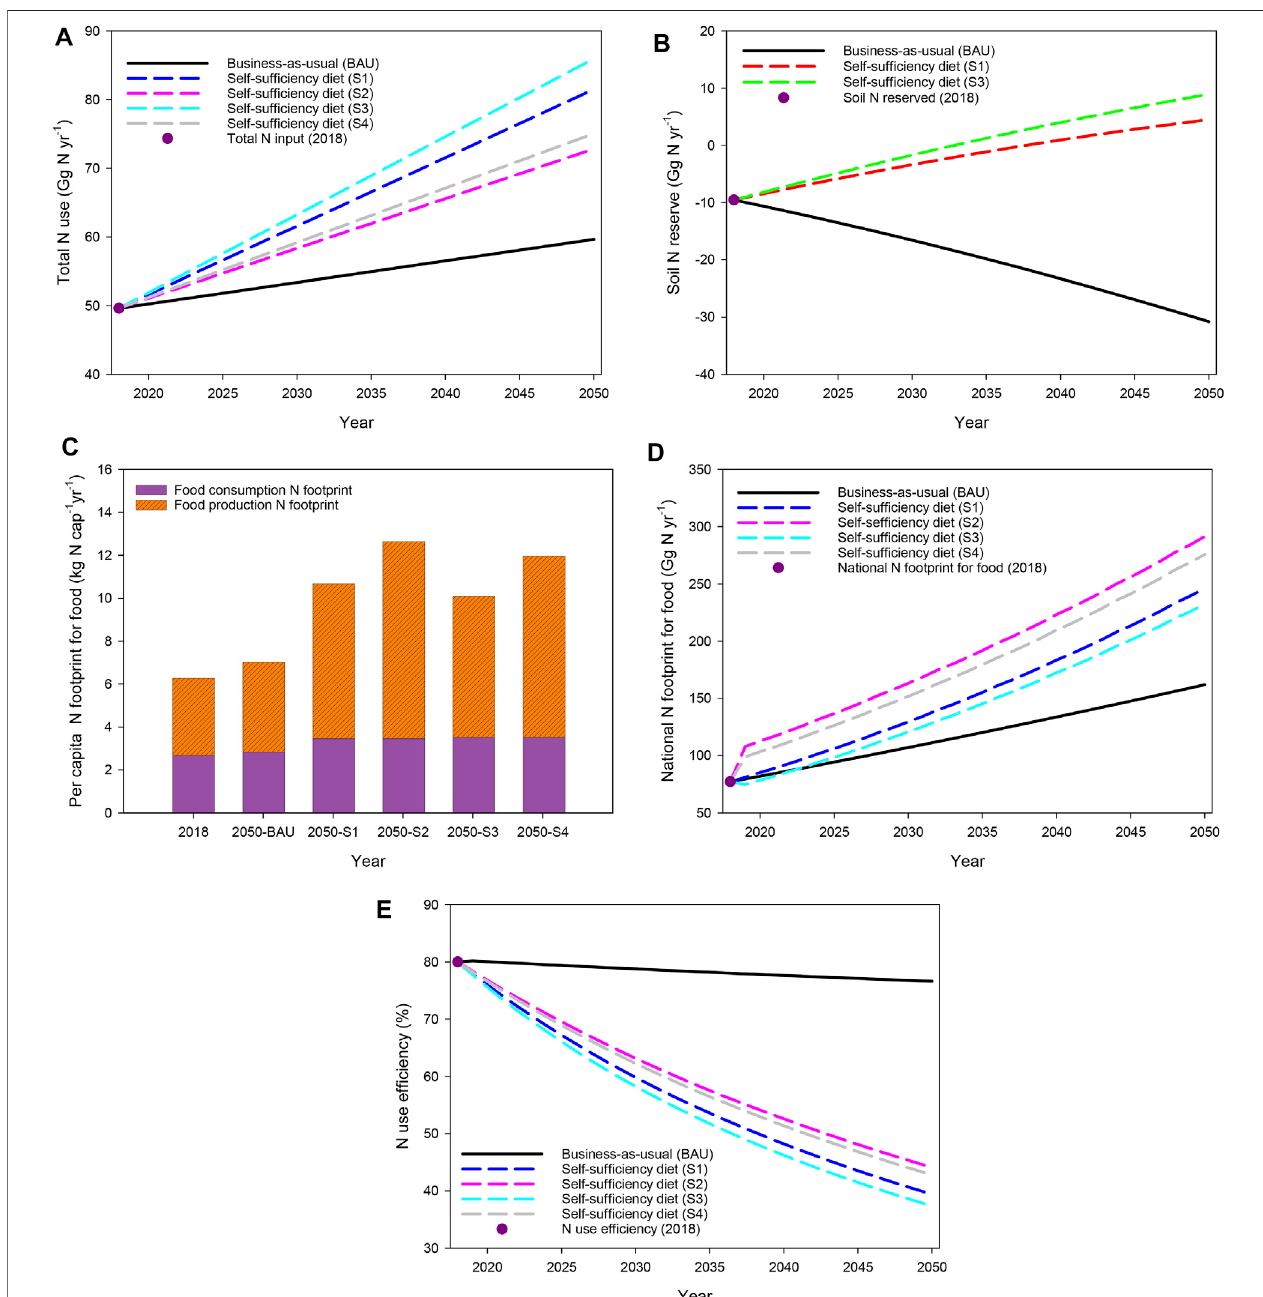
FIGURE 9| Future scenarios for total N use (A) , total soil N reserve (B) , per capita N footprint for food (C) , national Nfootprint for food (D) , and N use ef fi ciency (E) by 2050.